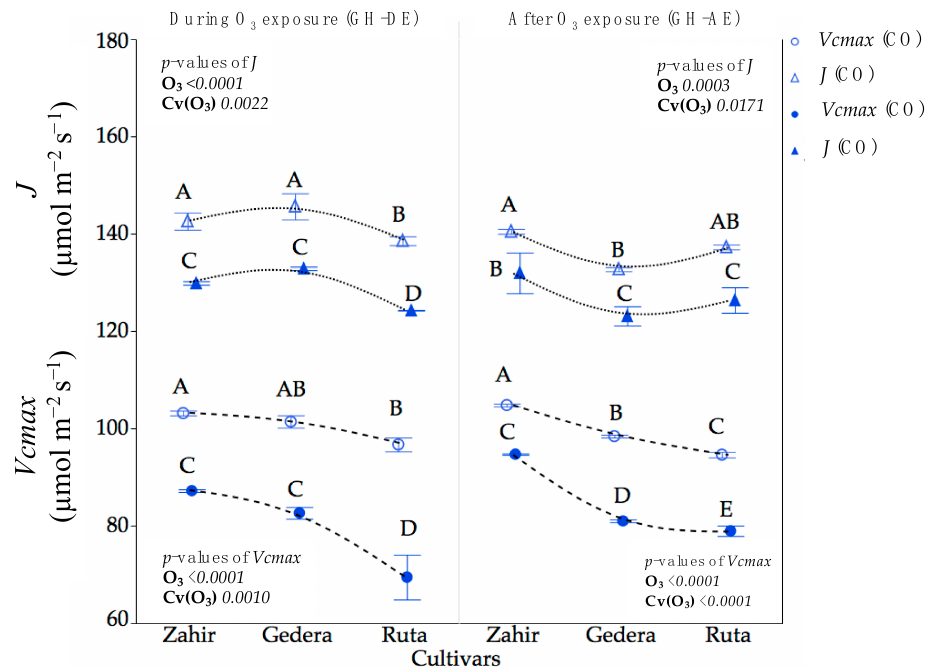
Figure 6. GH experiment—maximum carboxylation rate ( Vcmax ) and electron transport rate ( J ). Symbols (mean ± SE, n = 5) represents Vcmax and J of cultivars during exposure to O 3 (GH-DE) and afterward (GH-AE), for GH enriched with O 3 (EO) and the corresponding control (CO). Different letters over symbols indicate significant differences ( p < 0.05) according to Student’s t -test. p -Values of factors O 3 exposure (O 3 ) and cultivar within O 3 effect Cv(O 3 ) for parameters Vcmax and J by ANOVA are also shown.